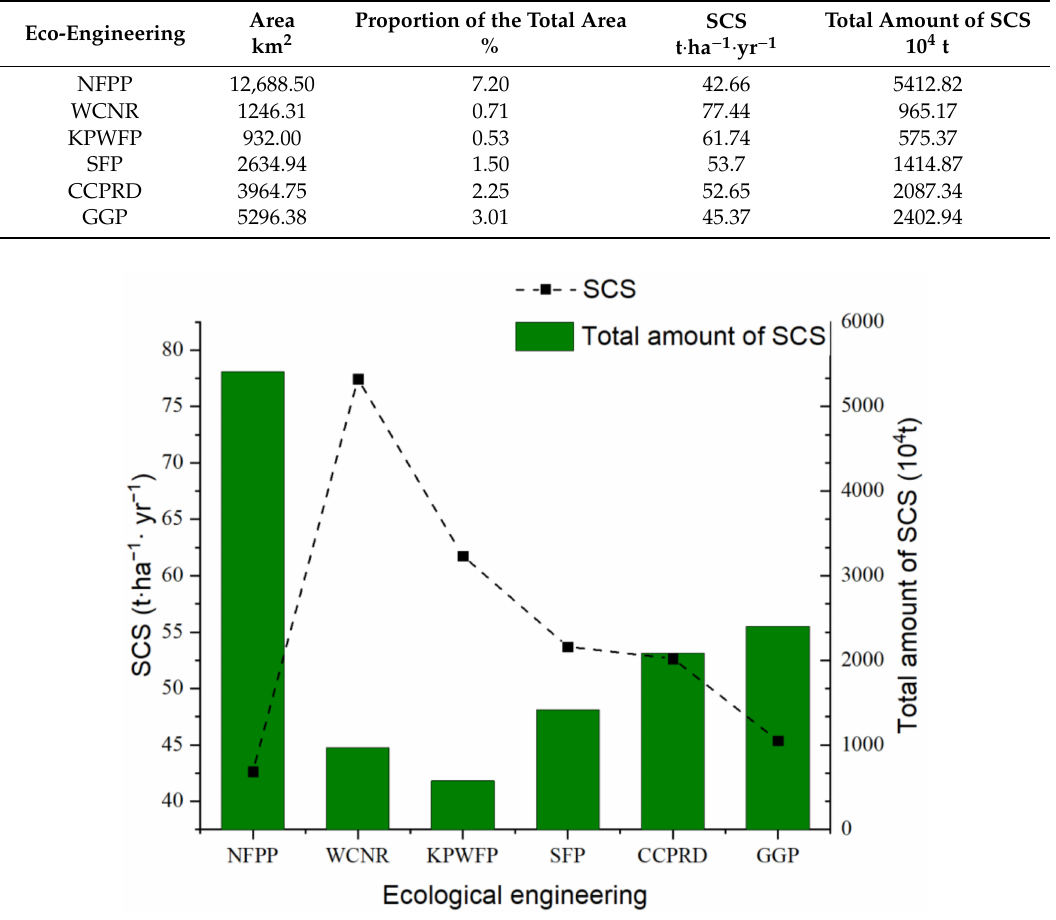
Figure 10. SCS and the total amount of SCS of the di ff erent ecological engineering projects on the Guizhou